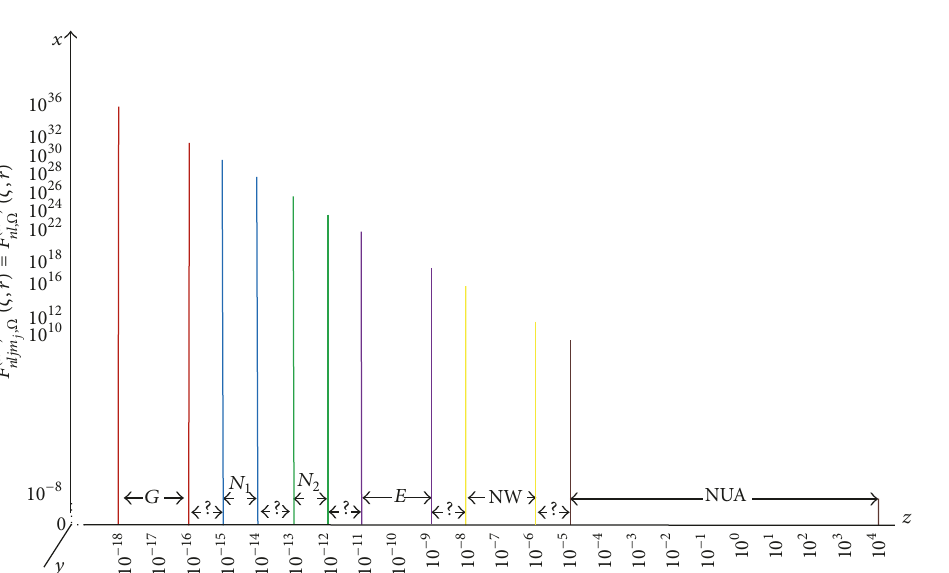
(10 −15 ≤ 𝑟 ≤ 10 −14 ) , Ω = 𝑁 (10 −13 ≤ 𝑟 ≤ 10 −12 ) , Ω = 𝐸 (10 −11 ≤ 𝑟 ≤ 1 2